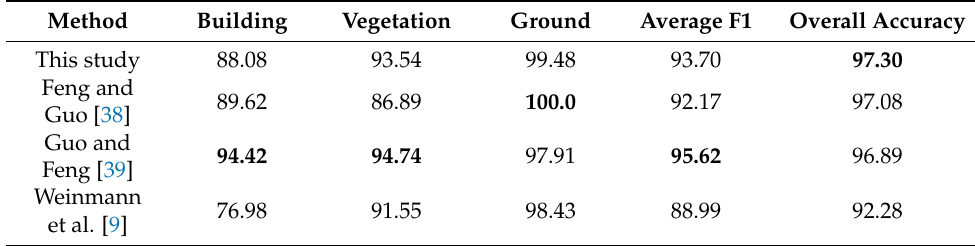
Table 8. Comparison with previous studies for the Oakland3D dataset. F1 score values were compared for each class. All values are given in %. The highest-obtained accuracies are shown as